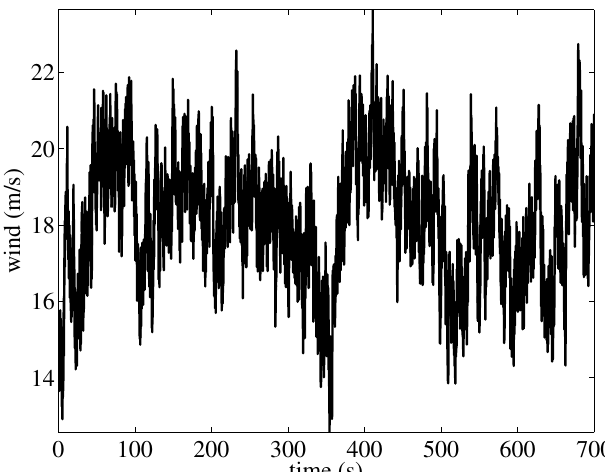
Figure 1. Hub-height wind speed for simulation tests. It is noteworthy that the simulated wind gust is from 350 to 400 s (approximately) where wind speed moves from 12 . 91 m/s up to the maximum of 22 . 57 m/s, followed by an abrupt decrease in the next 100